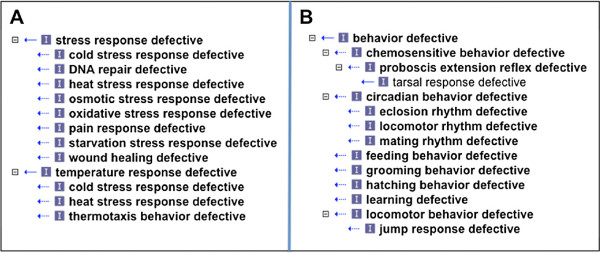
Autoclassification of processual phenotypes. Auto-classification of processual phenotypes, leveraging the GO. Terms in bold have equivalent class definitions. Panel A shows classification of stress response phenotypes. Panel B shows a portion of the behavioral phenotype classification.